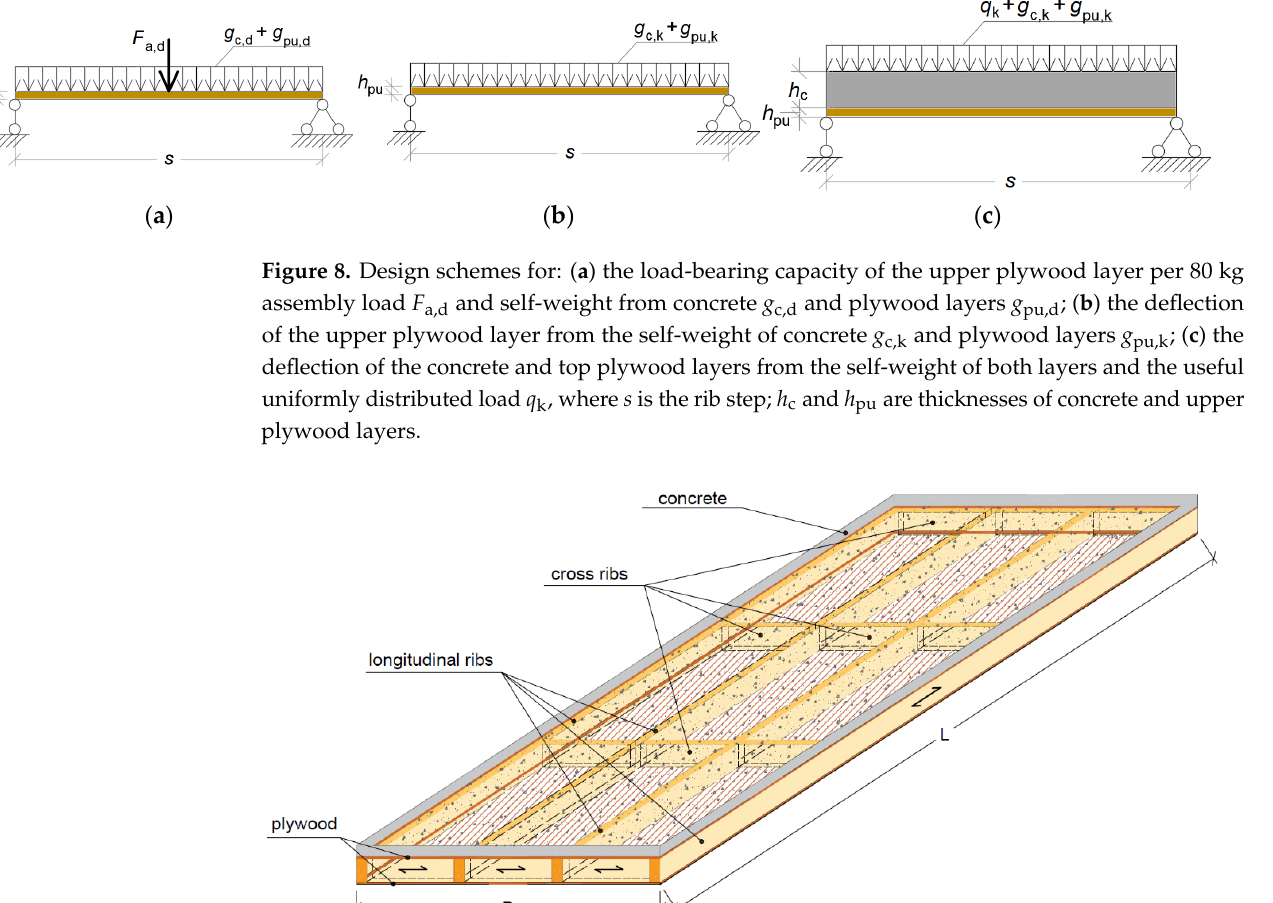
Figure 9. The view of timber–concrete composite with plywood rib panel with four longitudinal ribs and four rows of cross ribs.